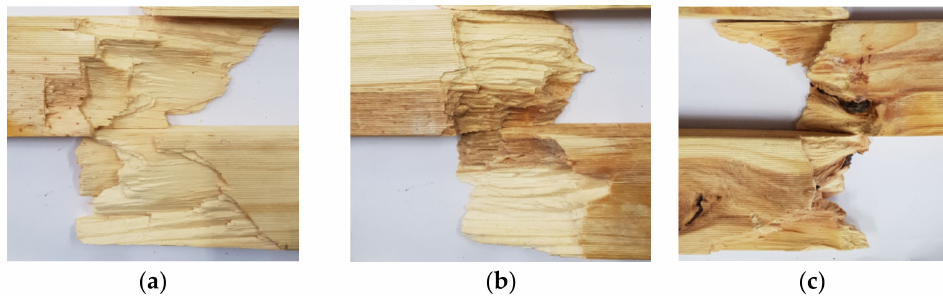
Figure 8. Some typical bending failure examples in ( a ) clear, ( b ) resin and ( c ) knots.